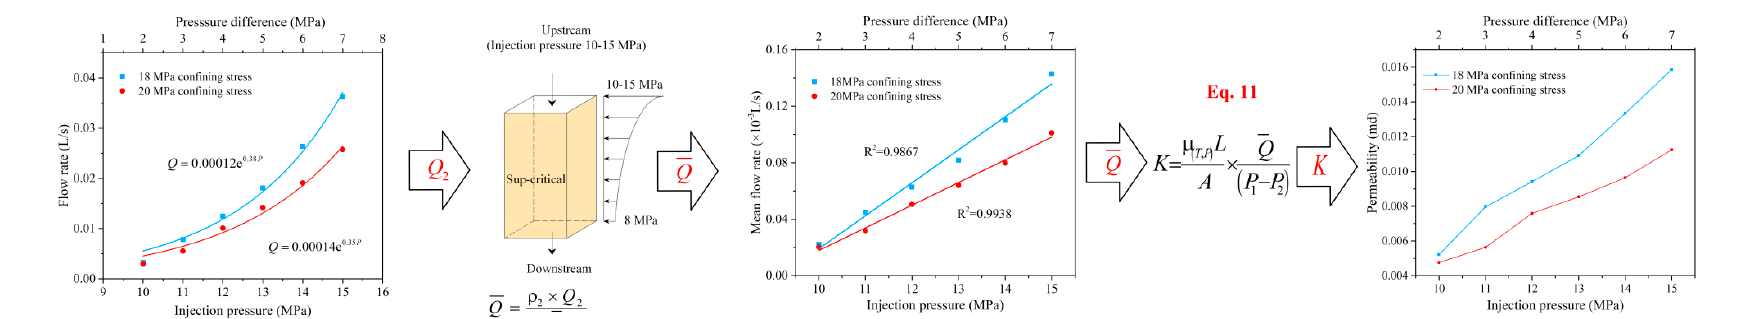
Figure 6. Sub-critical CO 2 flow behavior and permeability variation at 8 and 10 MPa confining pressures.